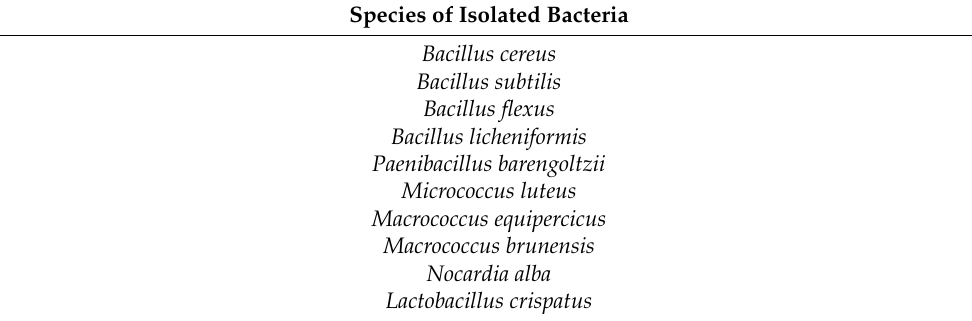
Table 4. Bacterial species identifications.